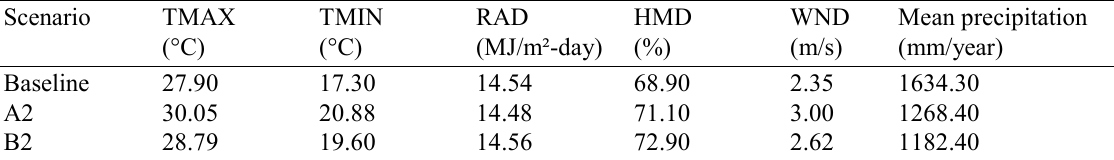
Table 3 Comparison between values of climate variables and current values for the climate scenarios used.